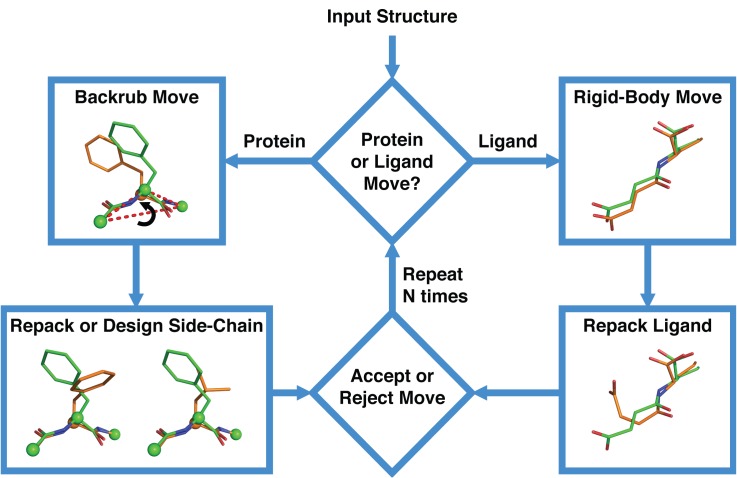
Flowchart outlining the coupled moves method.
The protocol starts with an input structure of a protein–ligand interaction, and performs either coupled protein or ligand moves. Each protein move involves a backrub move coupled to side-chain repacking or design and each ligand move involves a rigid-body rotation and translation coupled to ligand repacking. A move is either accepted or rejected depending on the change in energy, and a total of N moves are performed, where N can be set by the user.